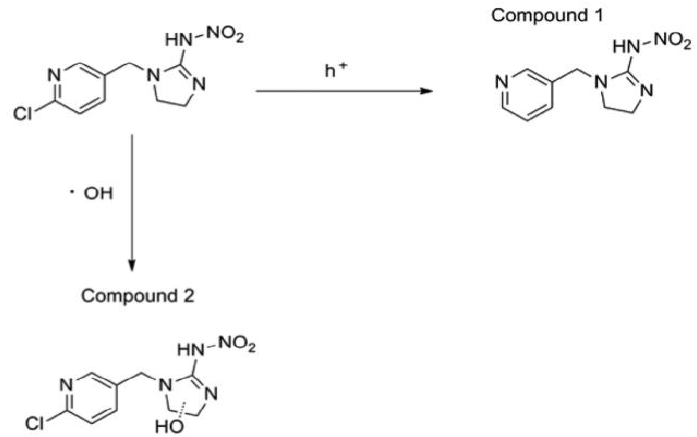
Figure8. Imidaclopriddegradationroutewithgraphiticcarbonnitrideasthephotocatalyst. Reproduced with permission from [71]. Copyright (2015) American Chemical